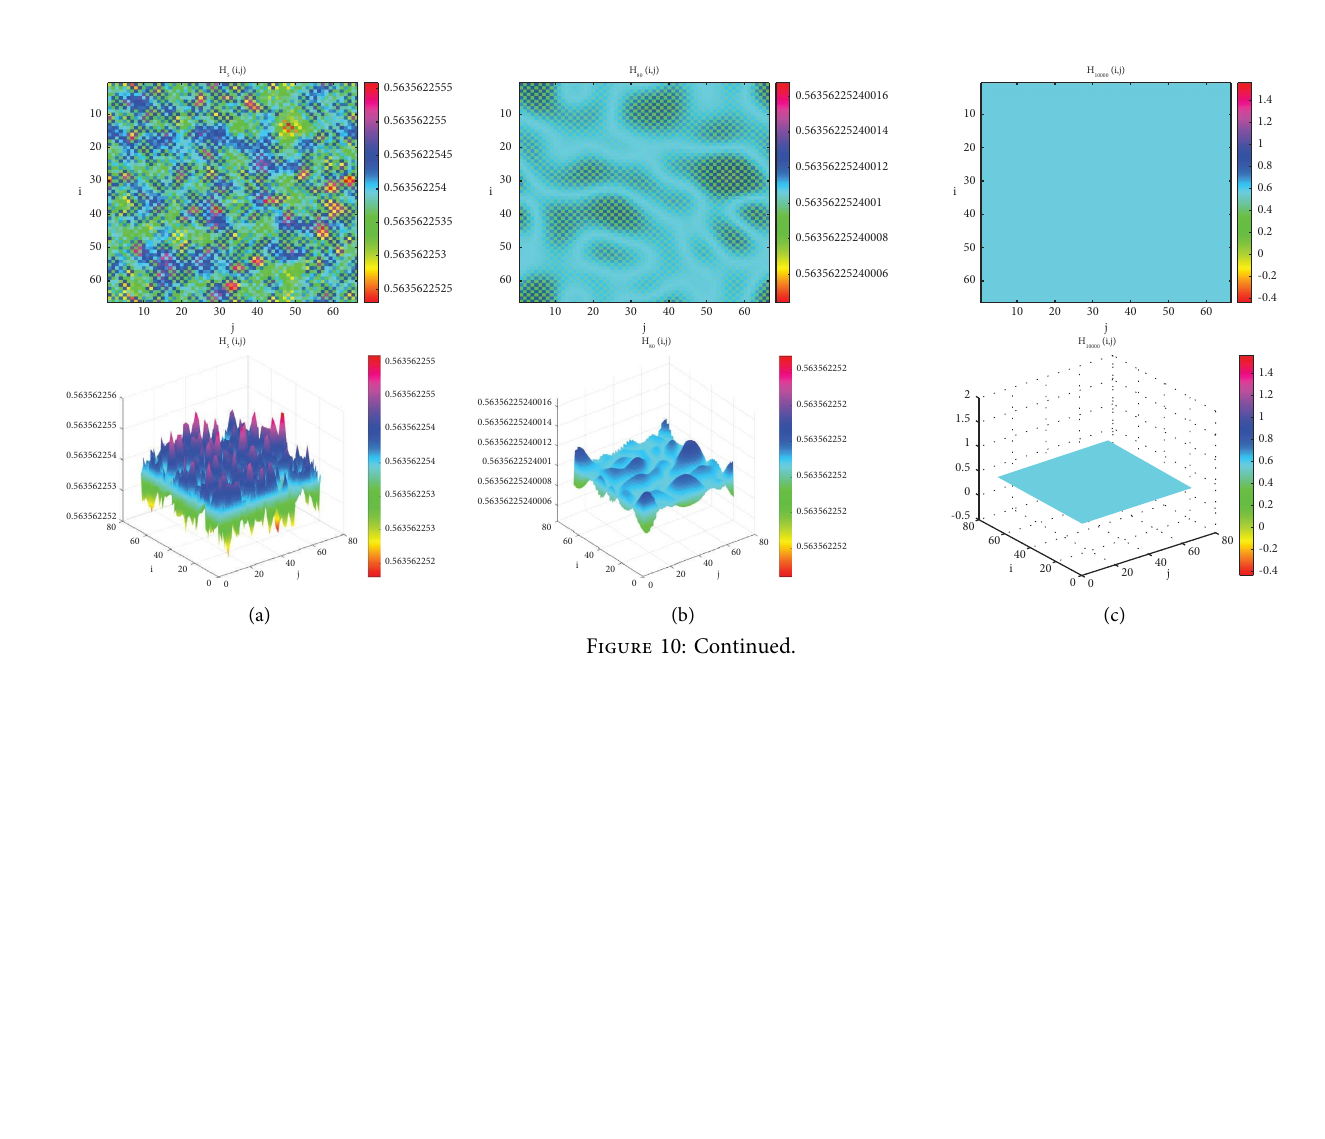
Figure 9: ( a ) , ( b ) are parameter planes of M with respect to d in (a), σ � σ ∗ in (b). Te results show that M < 1 in region I M � 1 in region III, and M > 1 in regions II,